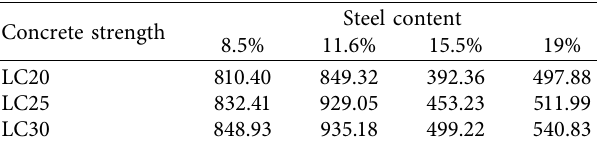
Figure 12: Load-strain curves of Z200-2.2-25. Table 4: Ultimate bearing capacity with various percentages of steel content of specimens (unit: MPa).